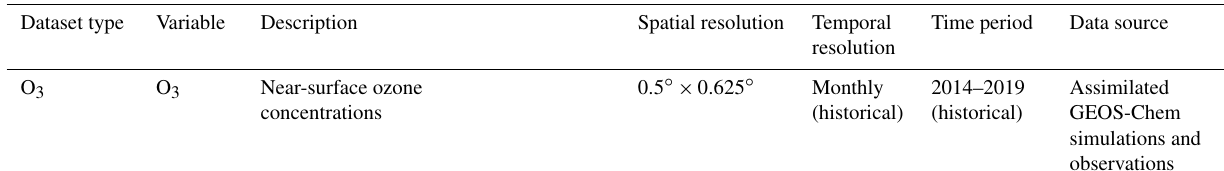
Table 1. Summary of detailed datasets used in this study. AVHRR: Advanced Very High Resolution Radiometer; ESA CCI: ESA Climate Change Initiative; SRTM: Shuttle Radar Topography